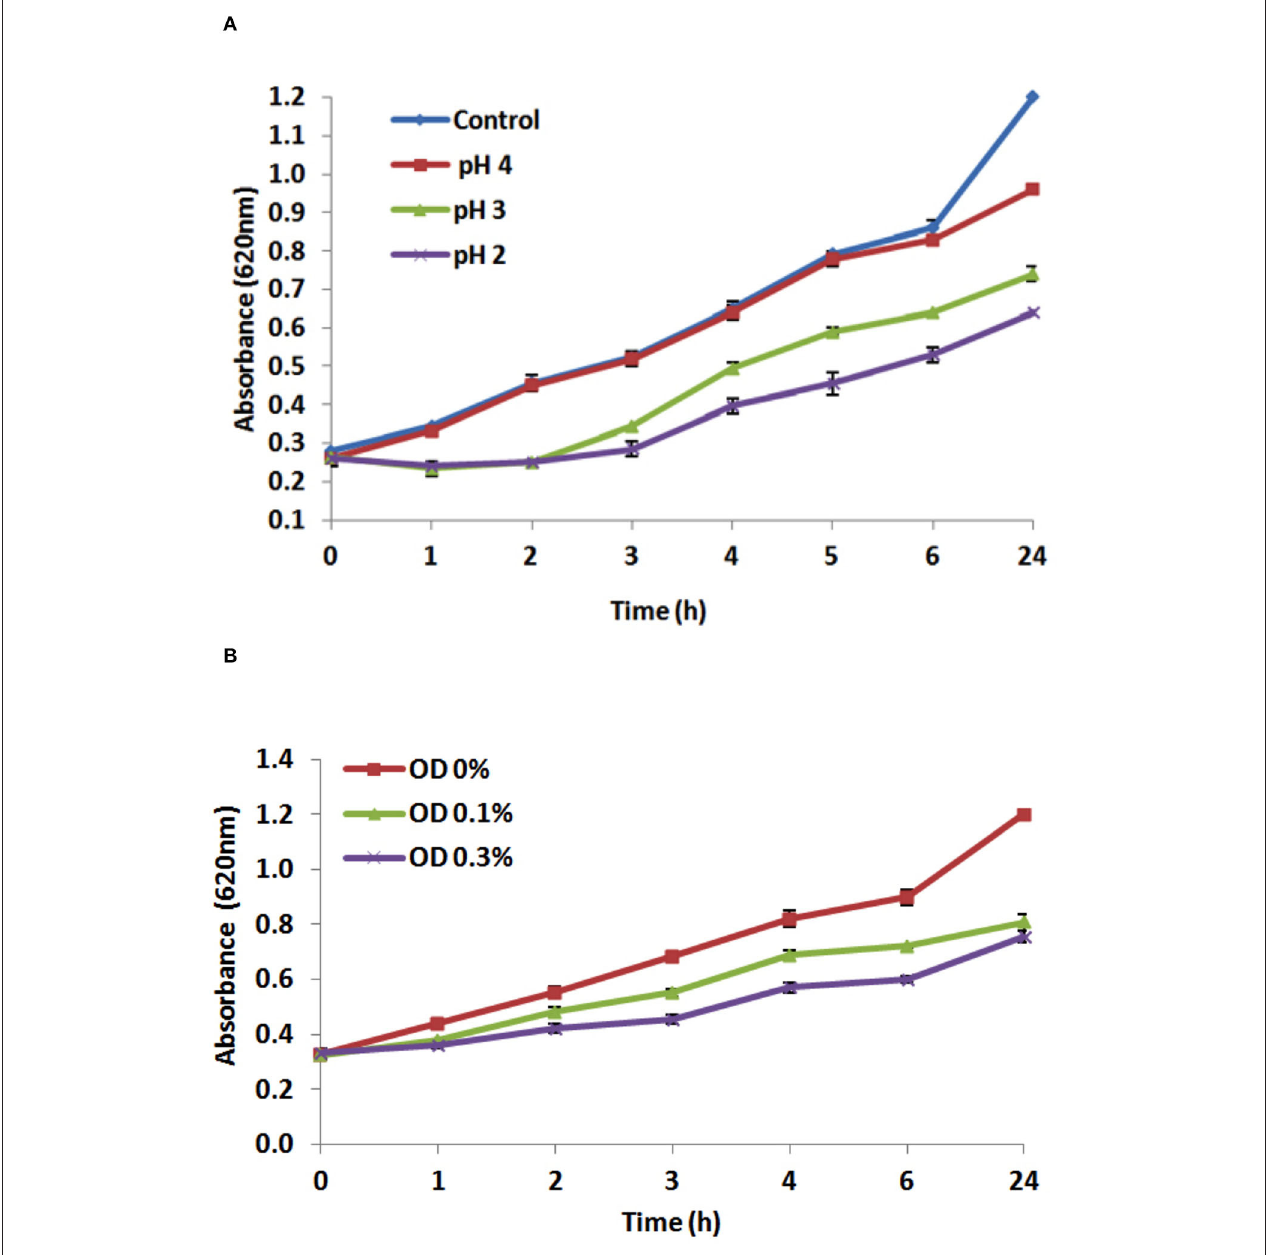
FIGURE 2 | Effect of different pH values (A) , and effect of different bile salts concentrations (0.0, 0.1, and 0.3%) (B) on the growth of L. plantarum EI6 at 37 ◦ C for 24h.